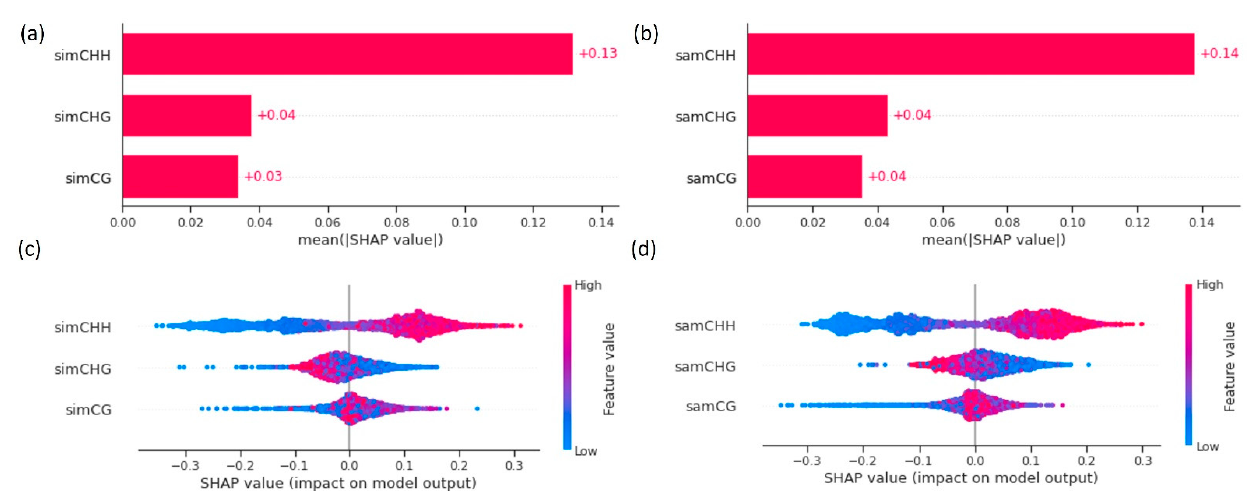
Figure 6. Correlations between recombination rates and the count of methylated cytosines for com- plete chromosomes, chromosome arms, and centromere region of rice varieties IR64 and Azucena. Blue and red colors correspond to positive and negative correlations, respectively. The higher the correlation value, the higher the color intensity.